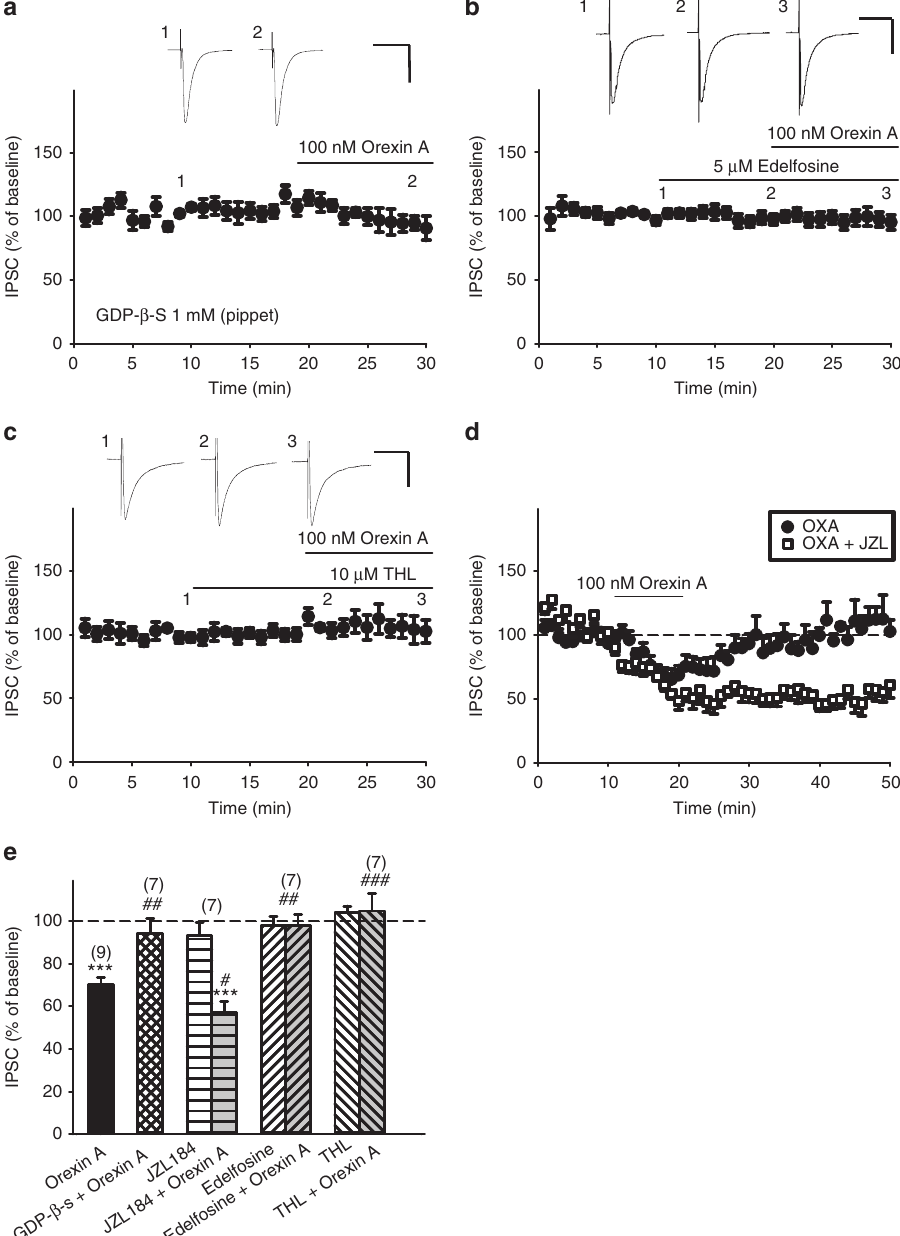
Figure 4 | Orexin A-induced IPSC depression was prevented by inhibitors of G-proteins, PLC b or DAGL, and was enhanced by a MAGL inhibitor. ( a – c ) The time course of the effect of orexin A on IPSC amplitude in slices pretreated with ( a ) GDP- b -S, a non-selective G protein inhibitor that was applied intracellularly through the patch pipette, ( b ) edelfosine (a PLC b inhibitor) or ( c ) THL (a DAGL inhibitor). Scale bars, 50ms, and ( a ) 400pA, ( b ) 100pA and ( c ) 200pA. ( d ) The time course of the effect of orexin A on IPSC amplitudes alone (filled circles) or in the presence of 1 m M JZL184 (open squares), a selective inhibitor of MAGL, which is the major catabolic enzyme of 2-AG. ( e ) Summarized effects of orexin A on IPSC amplitude in the absence ( n ¼ 9, black bar) or presence of 1mM GDP- b -S (hatched bar; n ¼ 7, P ¼ 0.005 ; t (14) ¼ (cid:2) 3.378), 5 m M edelfosine (right slashed grey bar; n ¼ 7, P ¼ 0.038; t (14) ¼ 2.286), 10 m M THL (left slashed grey bar; n ¼ 7, P o 0.001 ; t (14) ¼ (cid:2) 4.755) or 1 m M JZL184 (horizontal-lined bar; n ¼ 7, P o 0.001 ; t (14) ¼ (cid:2) 4.382), and the effect of the inhibitor alone (left or right slashed bar). *** P o 0.001 (one sample t -test); # P o 0.05, ## P o 0.01, ### P o 0.001 versus the group treated with orexin A alone (Student’s t -test). Data are expressed as mean ± s.e.m.